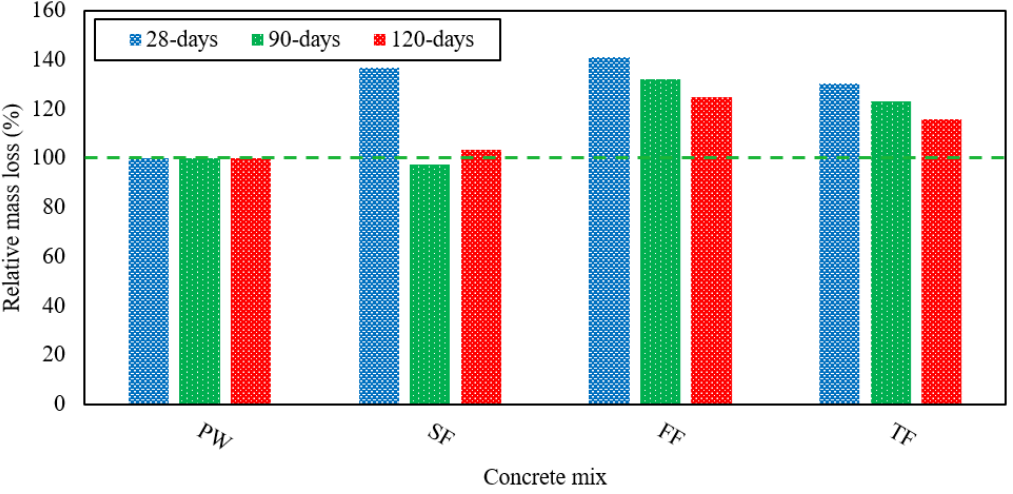
Figure 10. Mass loss of various RAGC mixes relative to FW at 28, 90, and 120 days of testing.